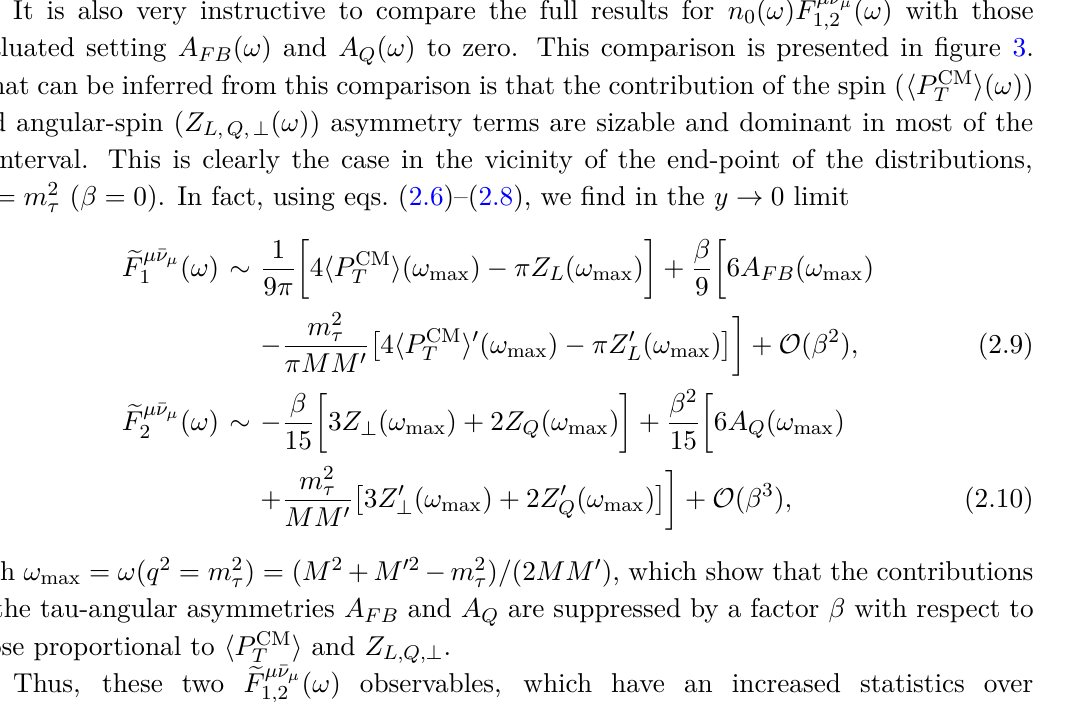
Figure 3 . Comparison of the full results (solid lines) for [3 a 0 ( ω ) + a 2 ( ω )] e F µ ¯ ν µ obtained setting A FB ( ω ) and A Q ( ω ) to zero (dashed lines). The muon mass is kept finite. The results have been obtained for the Λ b → Λ c τ ( µ ¯ ν µ ν τ )¯ ν τ sequential decay, within the SM and the NP model corresponding to Fit 7 of ref.